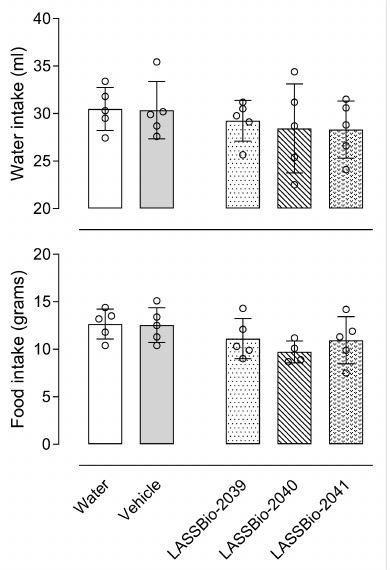
Figure 2. LASSBio-2039, LASSBio-2040 and LASSBio-2041 did not affect blood, bone marrow or red blood cells or platelet count nor hemoglobin and hematocrit levels. Mice were orally treated with each of the substances (30 µ mol/kg), water or vehicle. After 24 h bone marrow and blood were collected to measurements. Results are expressed as mean ± standard deviation ( n = 5–7).